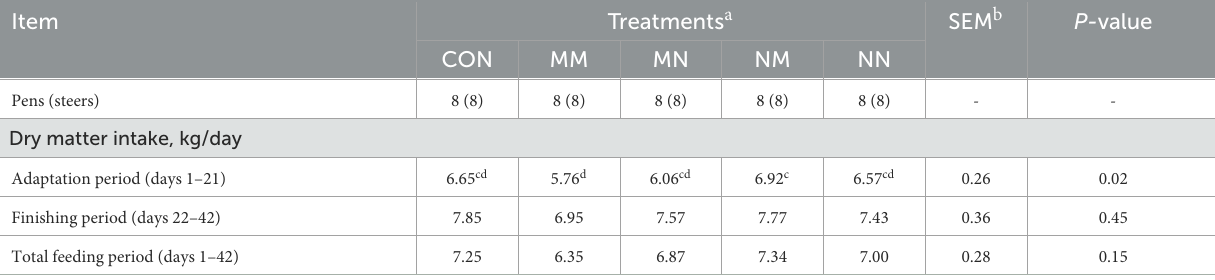
TABLE 2 Effects of feed additives on dry matter intake of finishing beef cattle—Exp.